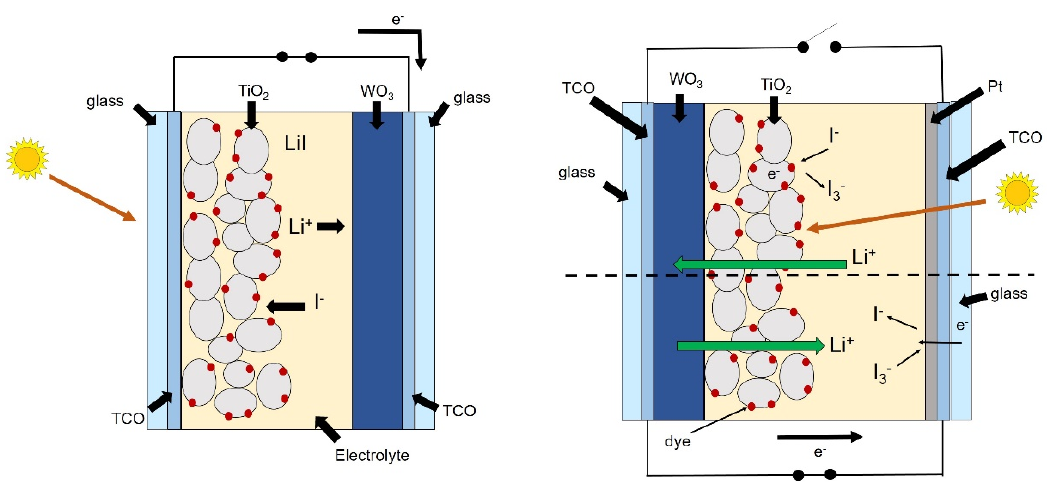
Figure 8. Cross-section of a typical photoelectrochromic (PEC) device with “separated architecture” ( left ). Coloration in open circuit ( upper part ) and bleaching in short circuit ( lower part ) of PEC device with “combined architecture” ( right ).